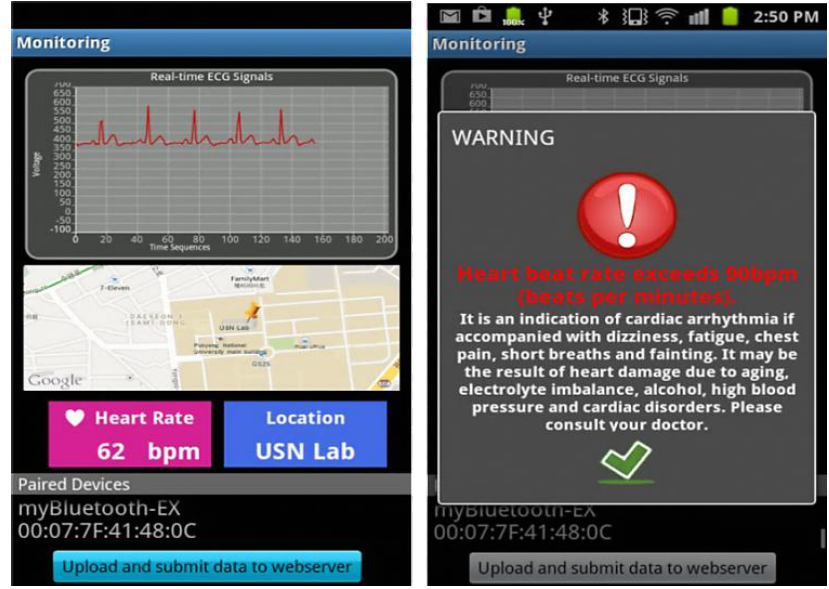
Figure 13. Display interface on a mobile device with ECG plotting, heart beat rate, location, and warning feedback for abnormal heart beat